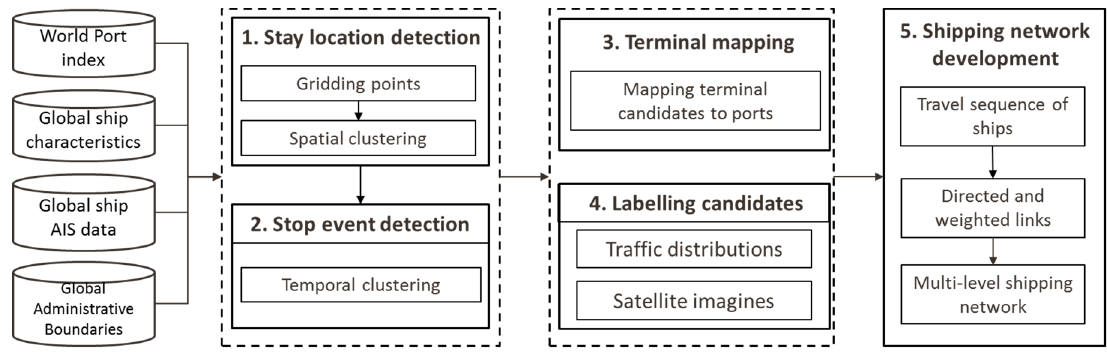
Figure 1. Bottom-up approach for Global Shipping Network (GSN) extraction: Datasets and principles.